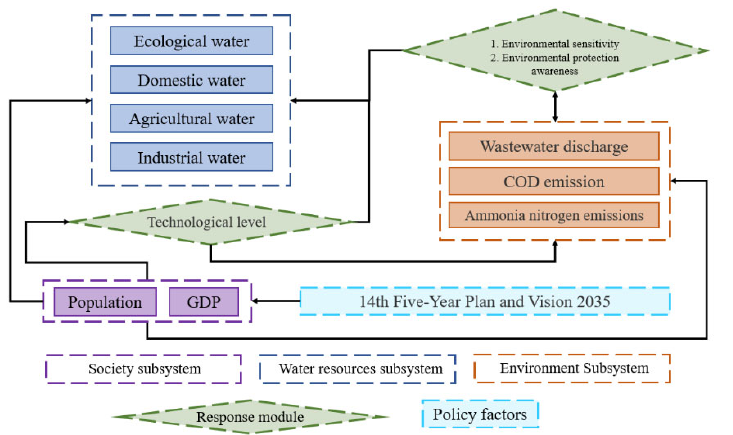
Figure 2. The mutual feedback relationship within the coevolution model. The variables of the society subsystem, water resources subsystem, environment subsystem, response module and policy factor are shown in purple, blue, orange, green and cyan, respectively.